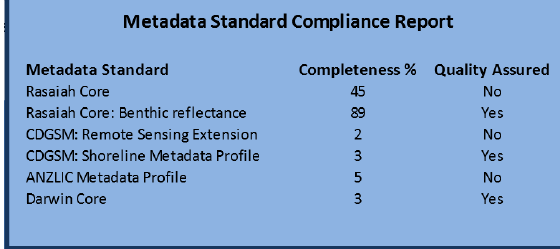
Figure 3 A screen image of a metadata standard compliance report for a selected field spectroscopy